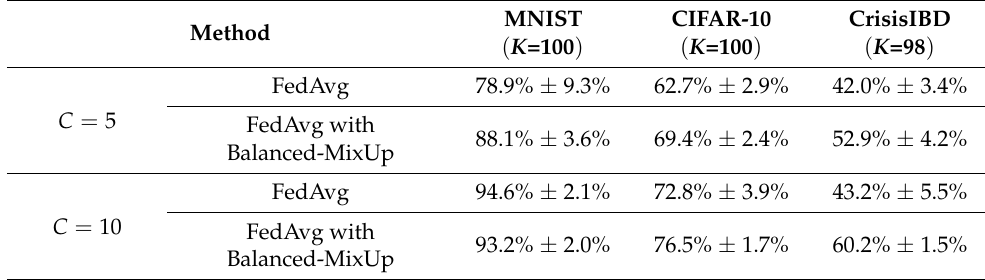
Table 5. Performance of FedAvg with and without